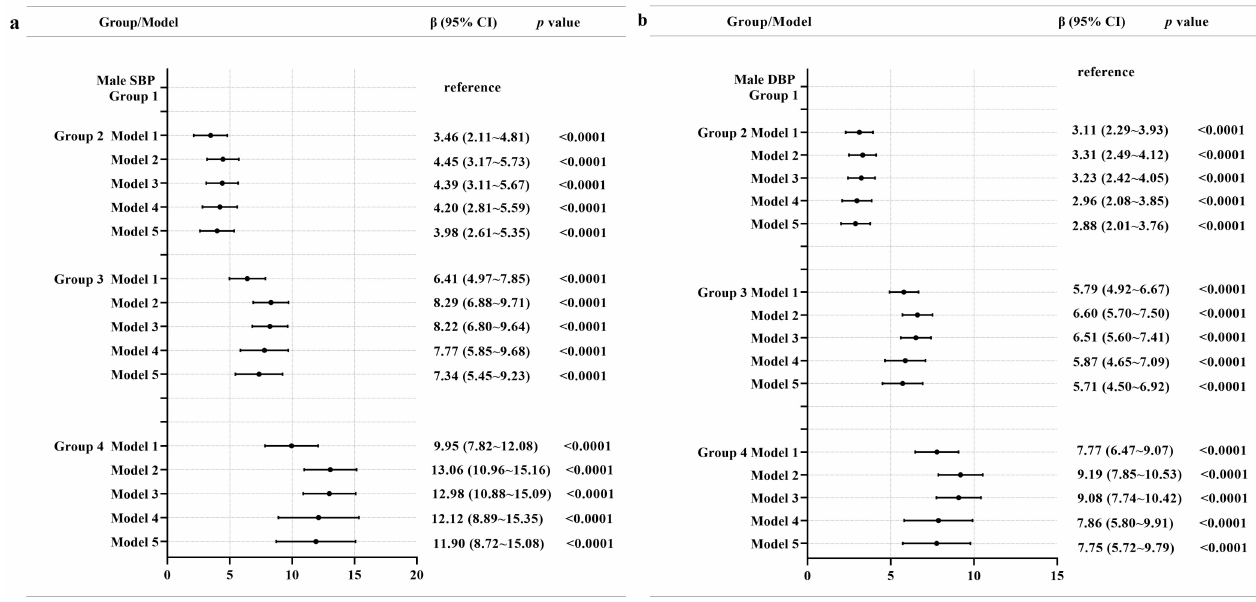
Figure 3. Associations between multiple trajectories and SBP ( a ) and DBP ( b ) in males. Note: Model 1 adjusted for no covariates. Model 2 adjusted for age, education level, geographic region (urban or rural), annual per capita household income, survey year, and follow-up time. Model 3 additionally adjusted for physical activity, current smoking status, current alcohol drinking status, Na intake, and K intake. Model 4 additionally adjusted for BMI and WC at baseline. Model 5 additionally adjusted for SBP and DBP at